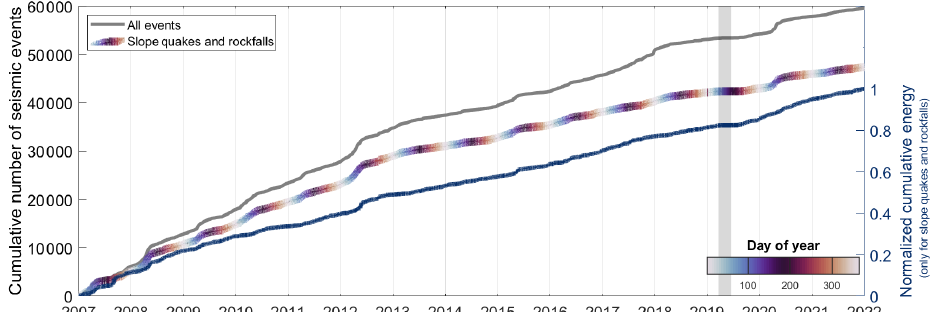
Figure 6. Cumulative number of seismic events and energy over time. Left axis: cumulative number of events including all detections (grey line) and restricted to events occurring on the slope (coloured line). The colour code highlights the seasonality. Right axis: normalized cumulative energy (dark blue line). The time range in 2019 shaded in grey corresponds to a period when the system was down and no data could be collected.